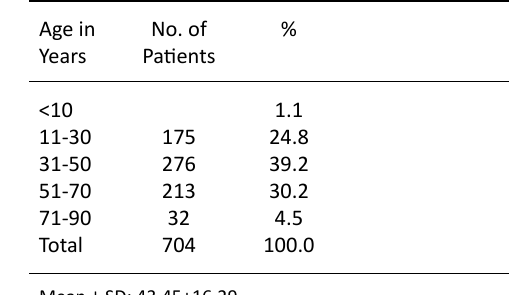
table 1. Age wise distribution of patients in COVID 19